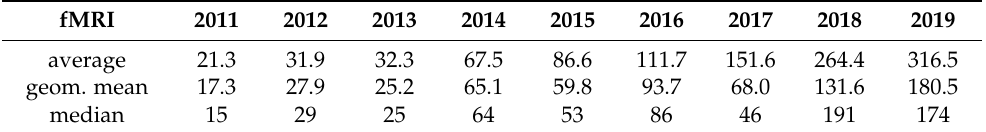
Figure 2. Median size of datasets used in MICCAI articles related to CT in each of the years 2011– 2019.